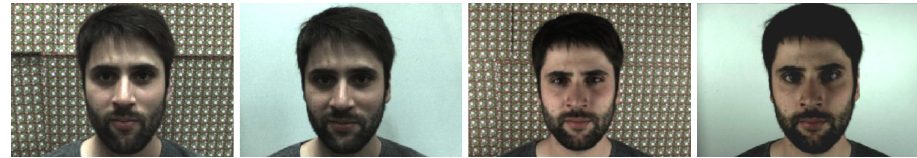
Figure 4. Lighting/background variations ( above : natural light, bellow : artificial